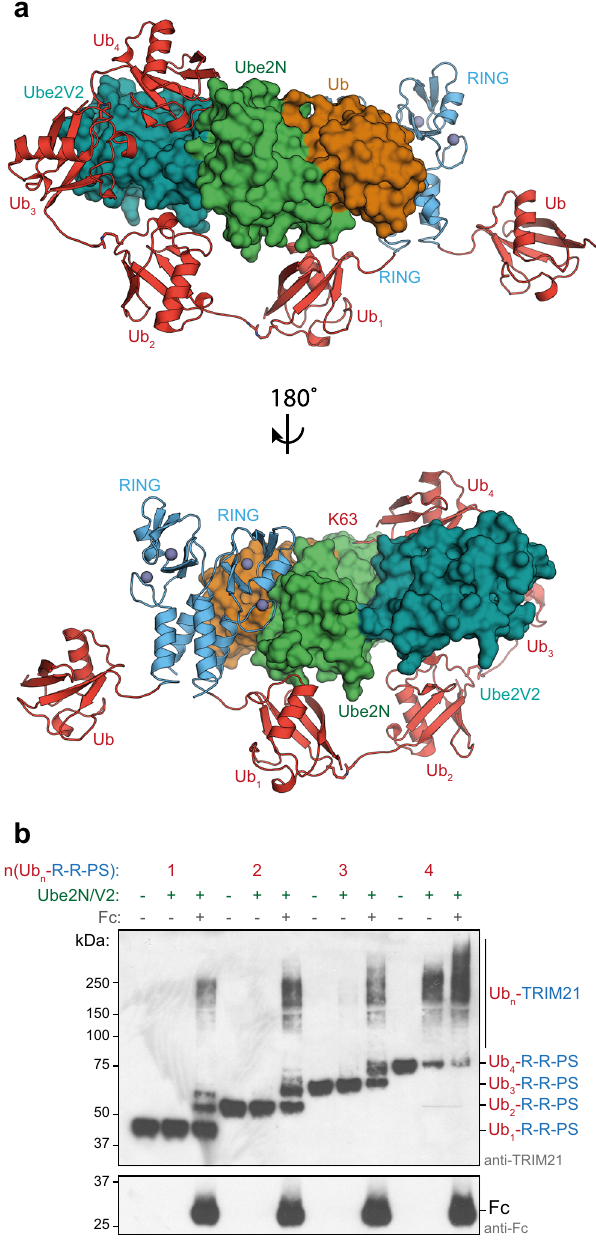
Fig. 4 The mechanism of RING-anchored ubiquitination in cis . a For ubiquitination in cis , the RING-anchored (blue) ubiquitin chain (red) must be suf fi ciently long to reach the active site on Ube2N~Ub/Ube2V2 (Ube2N in green, Ub in orange, and Ube2V2 in teal). The chain can go around two different routes, one shown here and the other in Supplementary Fig. 10. The ubiquitin chain was modeled using the Ub-R:Ube2N~Ub: Ube2V2 structure and a K63-linked Ub 2 structure (2JF5 (ref. 34 )) using PyMol. b Substrate (Fc)-induced self-ubiquitination assay of 100 nM Ub n - TRIM21 constructs. Reactions were incubated for 5 min at 37 °C. Western blots are representative of n = 3 independently performed experiments. Uncropped blots are provided in Source data. Ub ubiquitin, R RING, PS PRYSPRY, kDa kilo